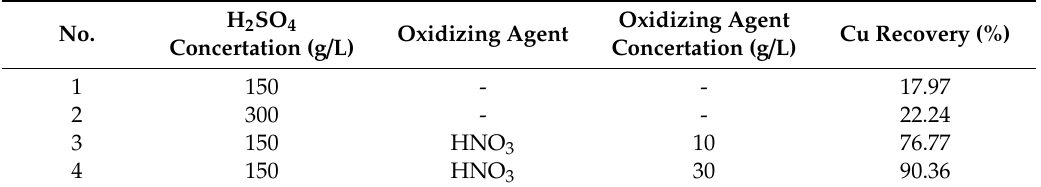
Table 4. E ff ect of oxidizing agent on copper recovery from CSD.